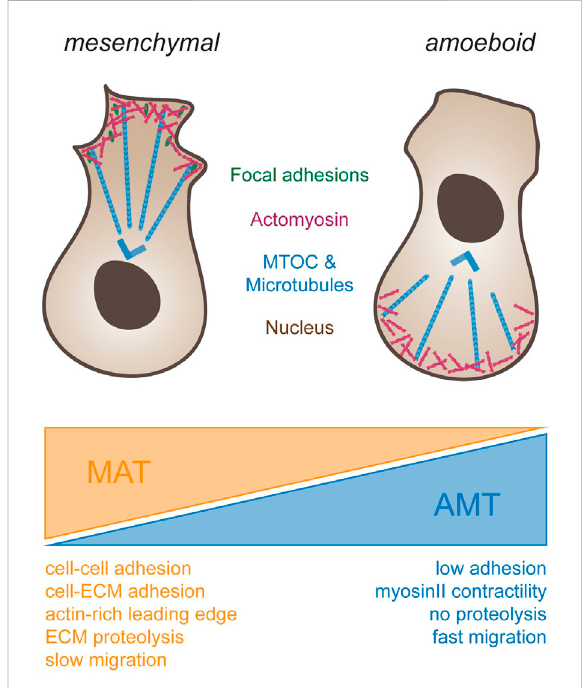
FIGURE 2 Different types of cell migration. To the left, schematic drawing of a cell using mesenchymal migration. Forces for propulsionaregeneratedbyconnectingactomyosin-basedforces (blue) through focal adhesions (green) to the substrate. Note that the MTOC (blue) is in front of the nucleus. To the right, amoeboid migration is depicted. Cells do not adhere to the substrate but rely on actomyosin-based compression of the cytosol at the back end of the cell for propulsion. Note that in immunecells,suchasdendriticcellsormacrophages,theMTOCis located behind the nucleus. Transitions from mesenchymal to ameboid migration (orange wedge, mesenchymal-amoeboid transition MAT) are promoted by low adhesion and Rho-ROCK driven Myosin-II activity (Friedl and Wolf, 2010; Graziani et al., 2022). Conversely, transition from amoeboid to mesenchymal migration (blue wedge, amoeboid-mesenchymal transition AMT) are induced by cell-cell and cell-ECM adhesions, actin-rich protrusions at the leading edge driven by Rac and Cdc42,